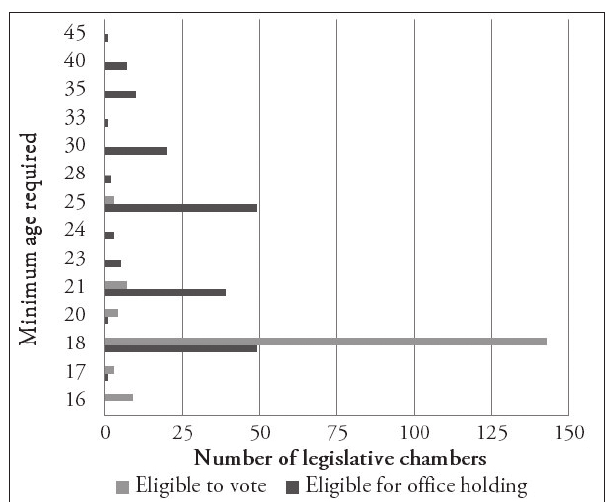
Figure 2: Voter-eligibility age gaps in